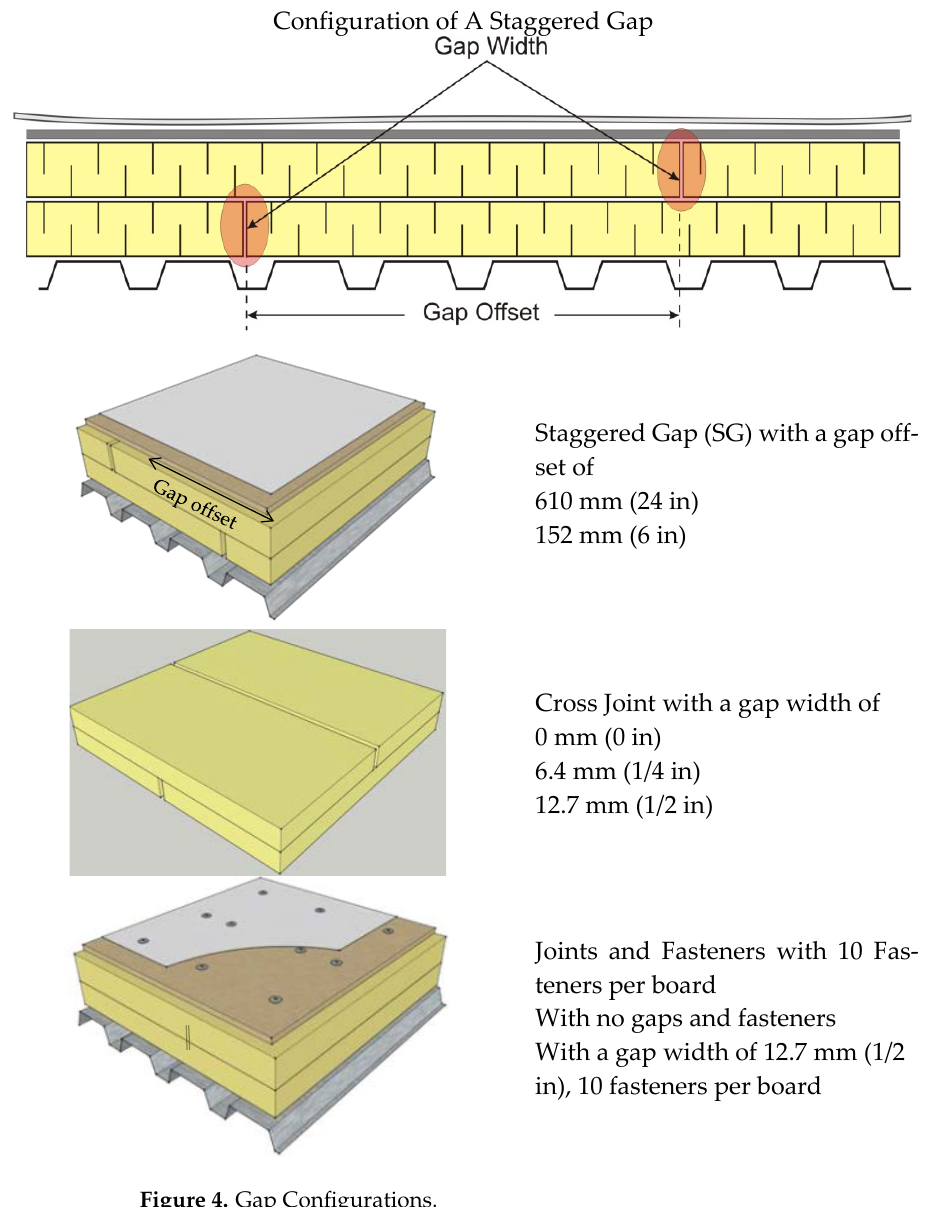
Figure 4. Gap Configurations.